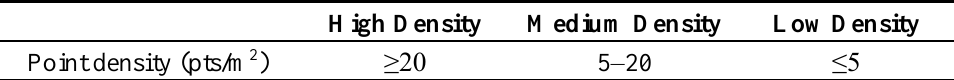
Table 2. Density range in three different